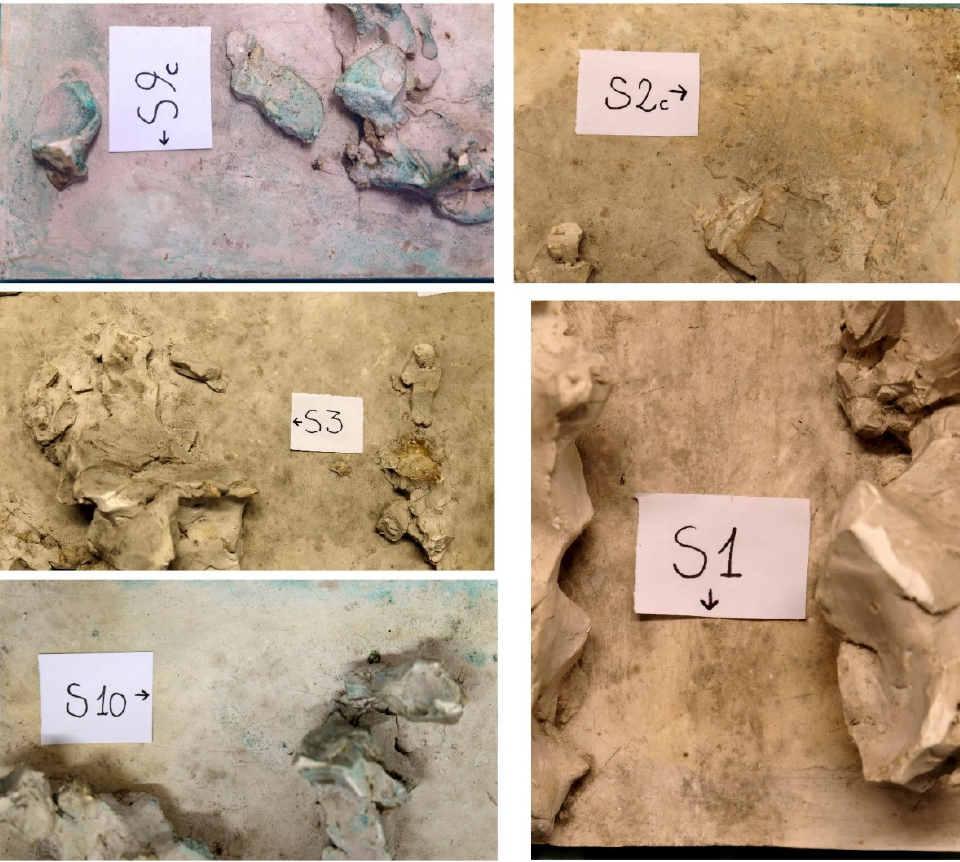
Figure 2. Sampling points: S9 visual observation with a digital green filter of the green patina on tile T9, S2 visual observation of a yellow-reddish discoloration on tile T3, S3 black/brown discoloration from tile T3, S10 black/brown discoloration associated with greenish stains from tile T13, and S1 yellow-reddish stains from T1 tile. Table 1. Samples collected for microbiological (code S) and measurement areas for reflection FTIR (code F) analyses in correspondence of the discolorations on the gypsum cast plaster. Green Patina/Chromatic